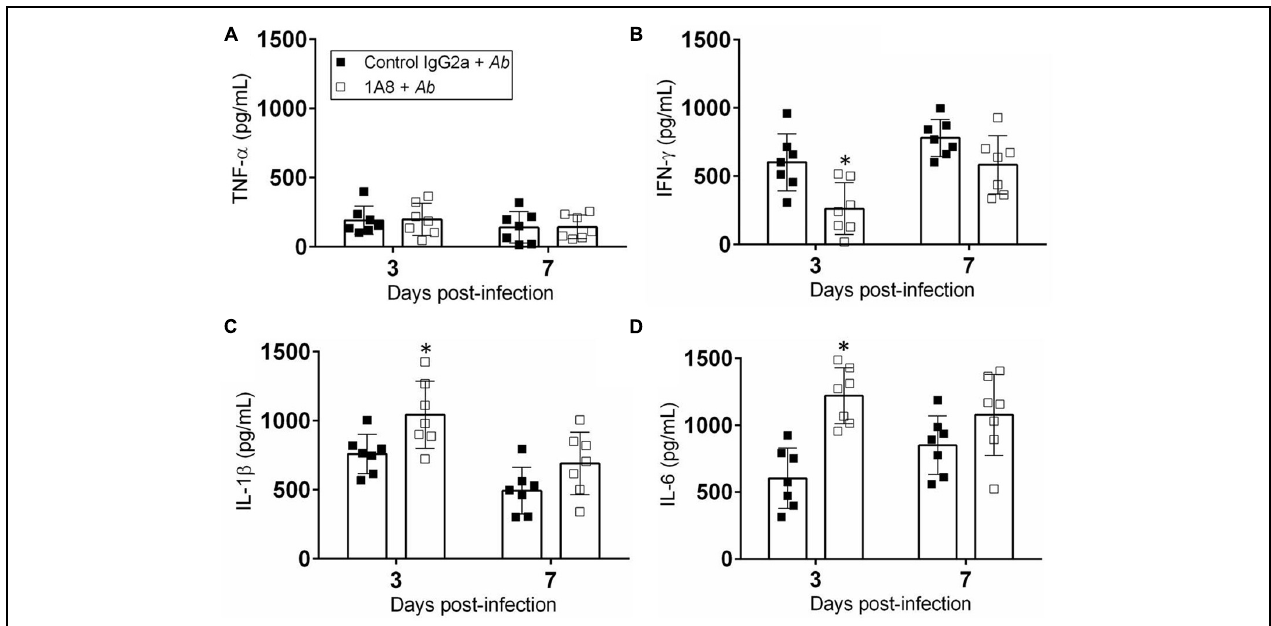
FIGURE 6 | Neutropenia altered pro-inflammatory cytokine production. Homogenates of extracted wounded tissue from control IgG2a + A. baumannii and 1A8 + A. baumannii mice, 3 and 7 days post-infection were prepared and the supernatants were analyzed for (A) TNF- α , (B) IFN- γ , (C) IL-1 β , and (D) IL-6 levels. Bars represent the mean values for seven clinical isolates (each symbol); error bars denote standard deviations. For (A–D) , asterisks denote P -value significance ( ∗ P < 0.05) calculated using student’s t -test analysis. Cytokine quantification was performed thrice with similar results obtained.